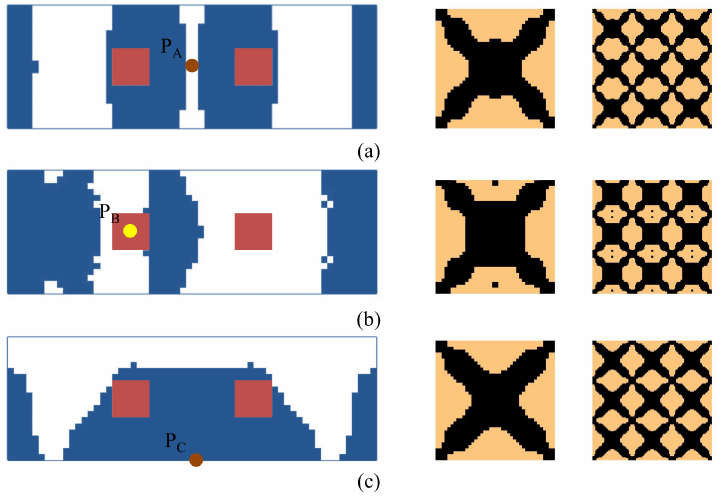
Figure 26. Design results of the composite plate clamped with two opposite edges are shown in Figure 15. ( a – c ) correspond to the excitation points P A , P B , and P C , respectively. The excitation frequency is 50–100